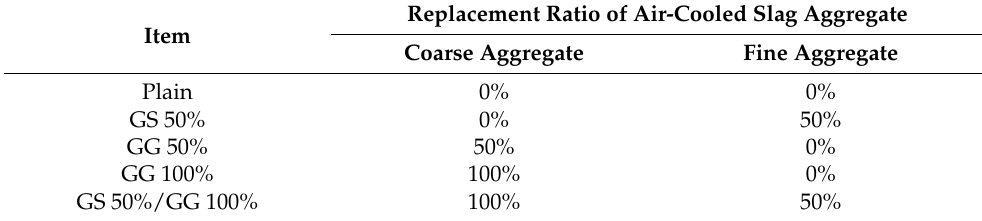
Table 8. Rural-road pavement concrete mixing test plan.